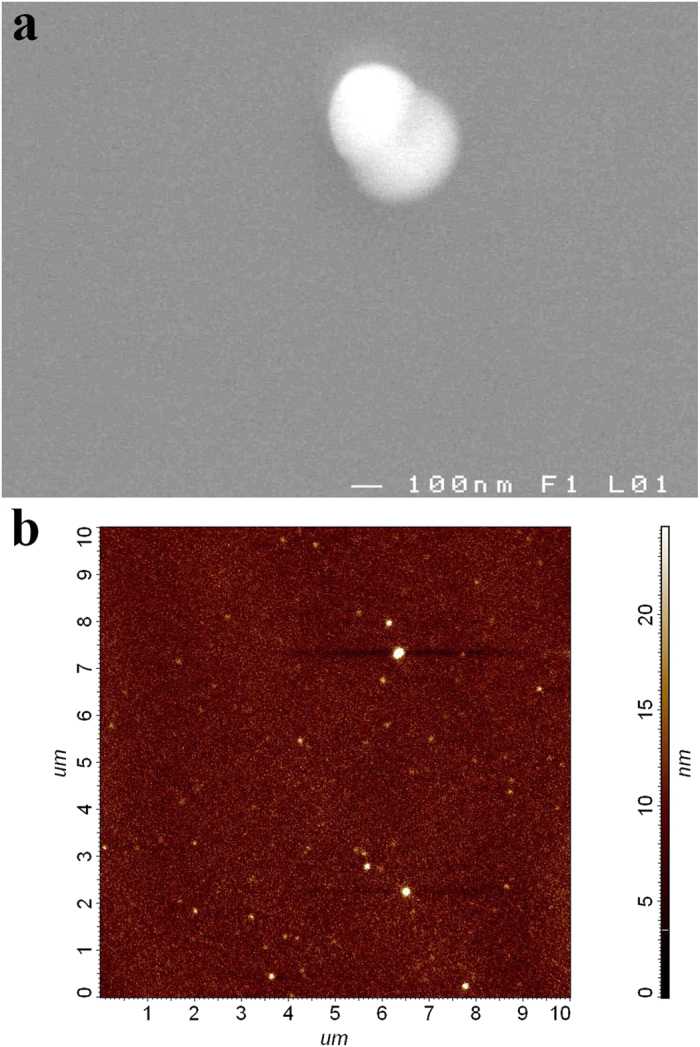
SEM micrograph (a) and AFM scan (b) of as-deposited Ge8Sb2Te11 thin film.